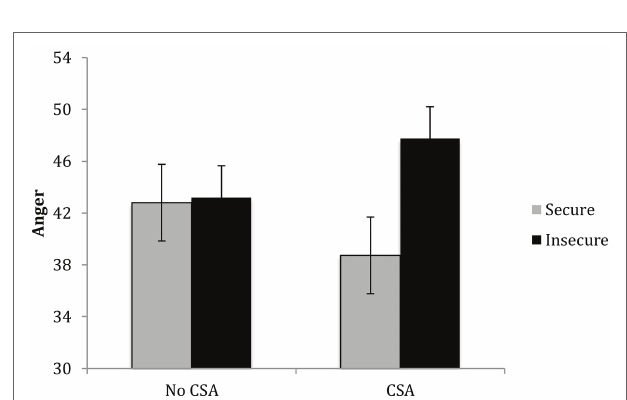
FIGURE 1 | Children’s childhood sexual abuse (CSA) history and attachment interact in predicting their post-traumatic stress disorder (PTSD) symptoms.